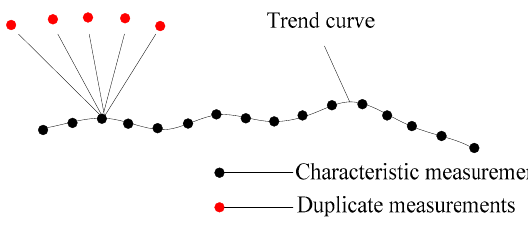
Figure 11. Structure of measurements.